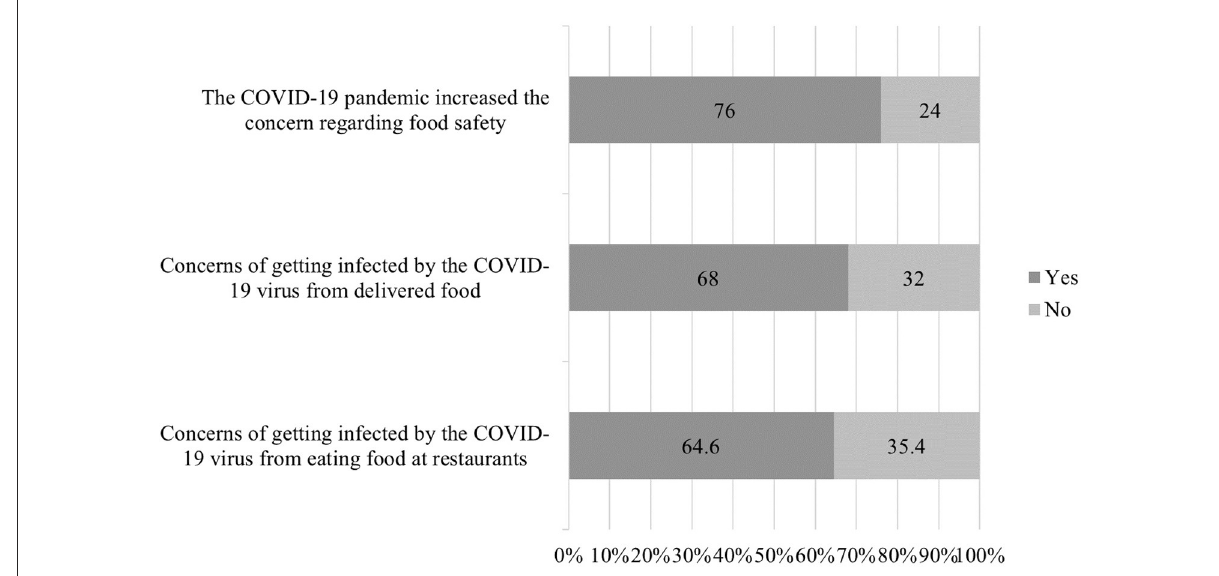
FIGURE3 Attitude toward food safety and COVID-19 ( n = 325).